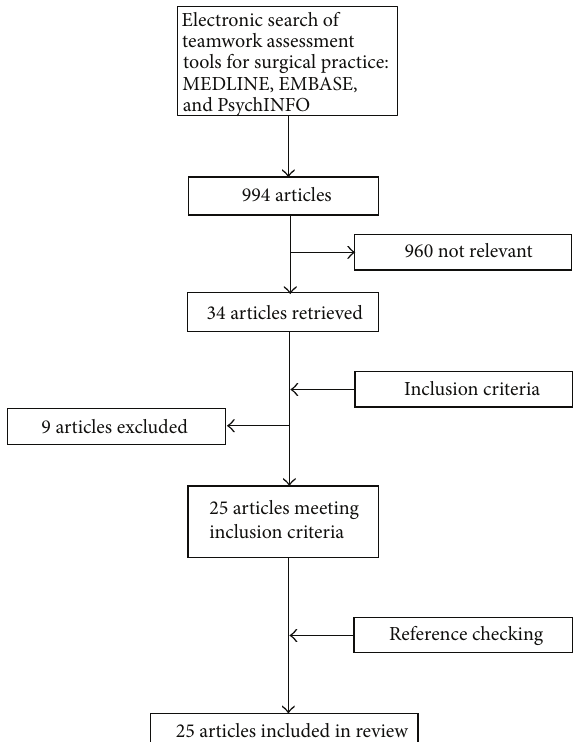
Figure 1: Flowchart depicting literature search strategy and